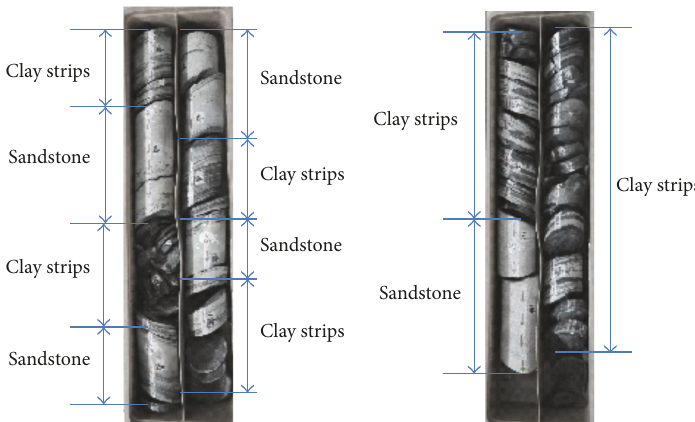
Figure 1: Full diameter core from a selected well.